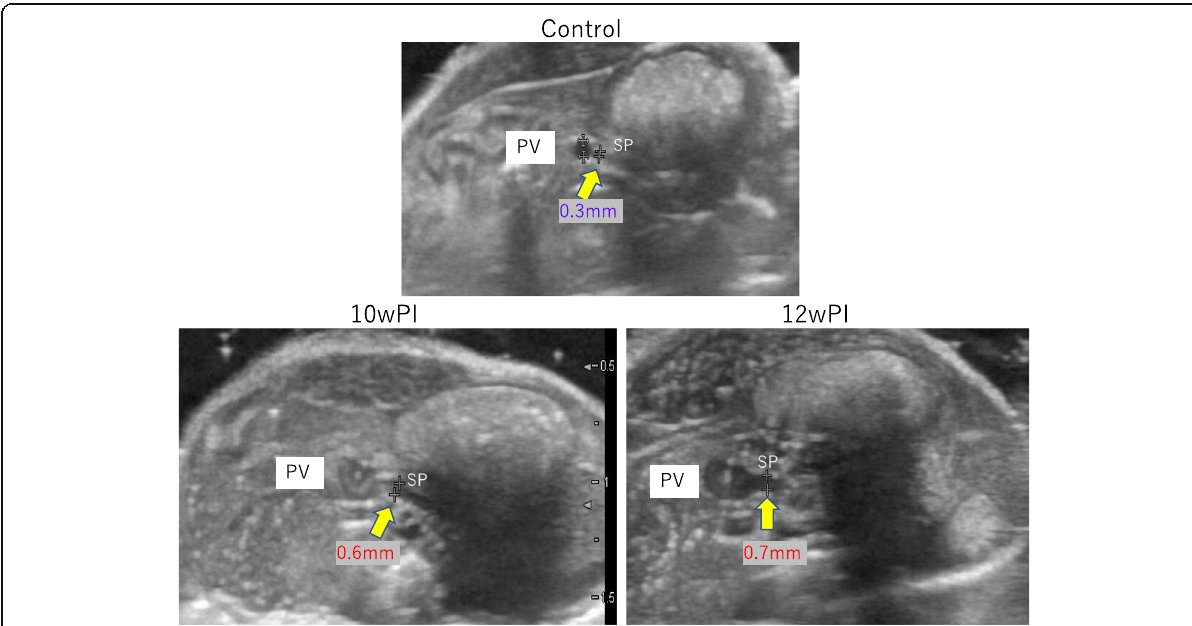
Fig. 6 Dilatation of the splenic vein. The diameter of the splenic vein (SP) was around 0.3 mm in control mice at the site of divergence from the portal vein (PV) but doubled in size at 10 and 12 weeks PI